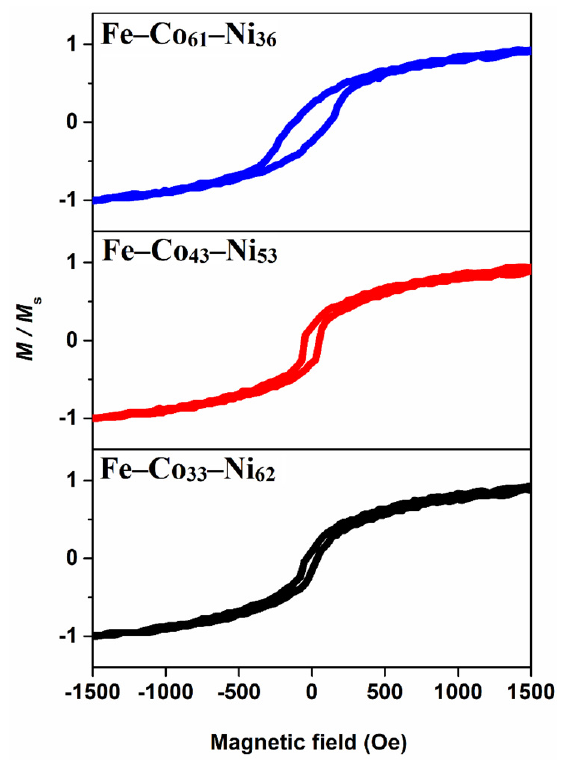
Figure 7. Hysteresis loops of the samples with different compositions.